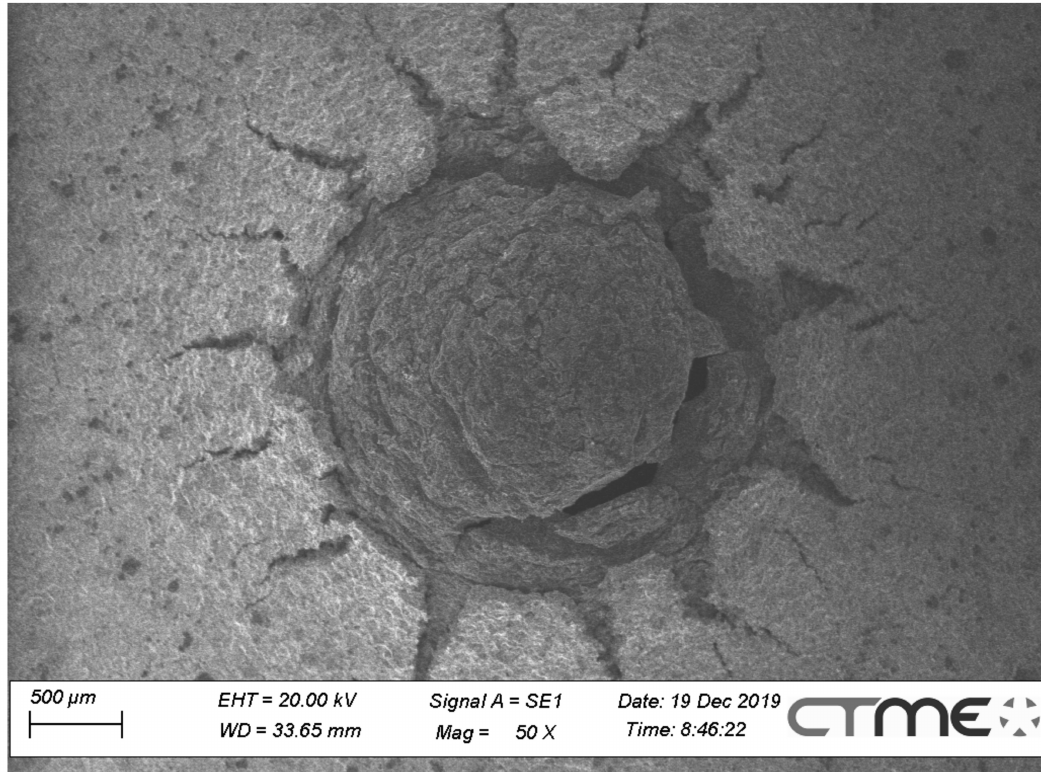
Figure 9. SEM image of the observed Small Punch Test (SPT) fracture (Test